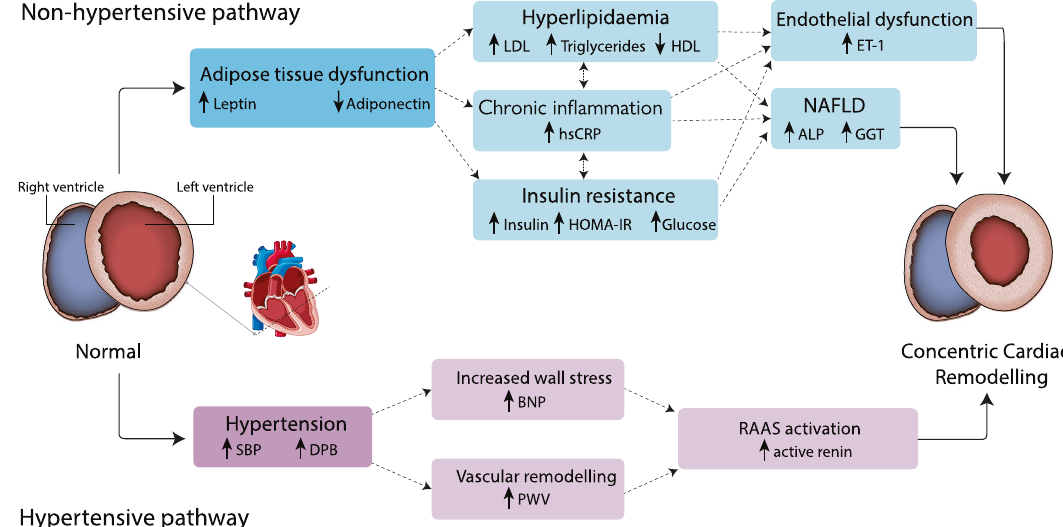
Fig. 1 Hypertensive and non-hypertensive molecular pathways to concentric cardiac remodelling. NAFLD non-alcoholic fatty liver disease, ALP alkaline phosphatase, GGT gamma-glutamyltransferase, hsCRP high-sensitivity C-reactive protein, LDL and HDL low- and high-density lipoprotein, HOMA-IR Homeostatic Model Assessment for Insulin Resistance, PWV pulse-wave velocity, BNP brain natriuretic peptide, ET-1 endothelin-1, SBP and DBP systolic and diastolic blood pressure. Graphic element credit: